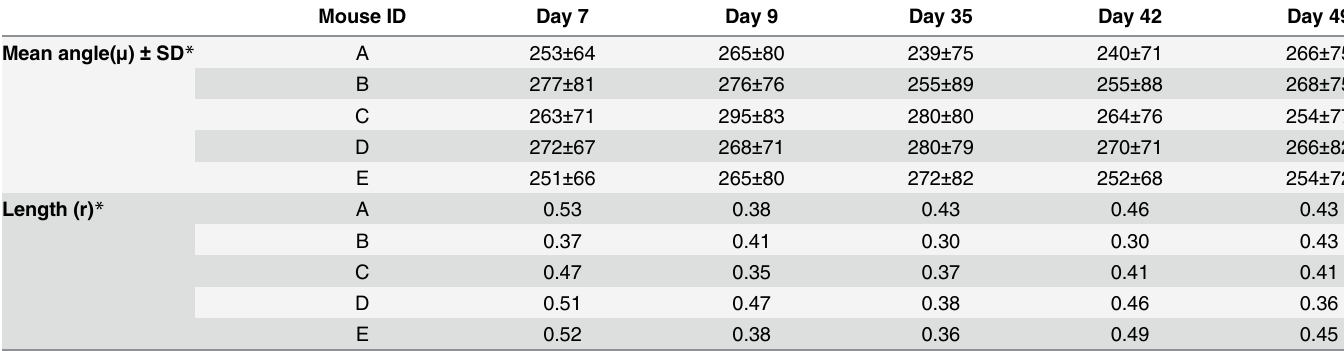
Table 2. Vector properties of locomotor activity rhythms in individual